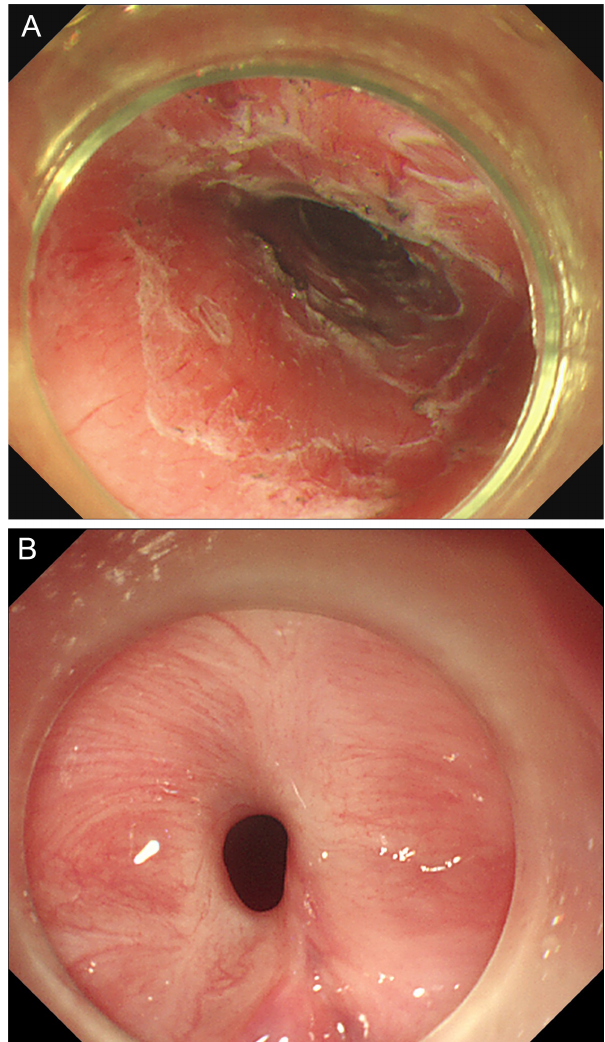
Figure 1. A case with extremely severe esophageal stricture after whole circumferential endoscopic submucosal dissection. (A) Endoscopic submucosal dissection resulted in a whole circumferential mucosal defect. (B) Three weeks after endoscopic submucosal dissection, the mucosal defect revealed a complete stricture that became